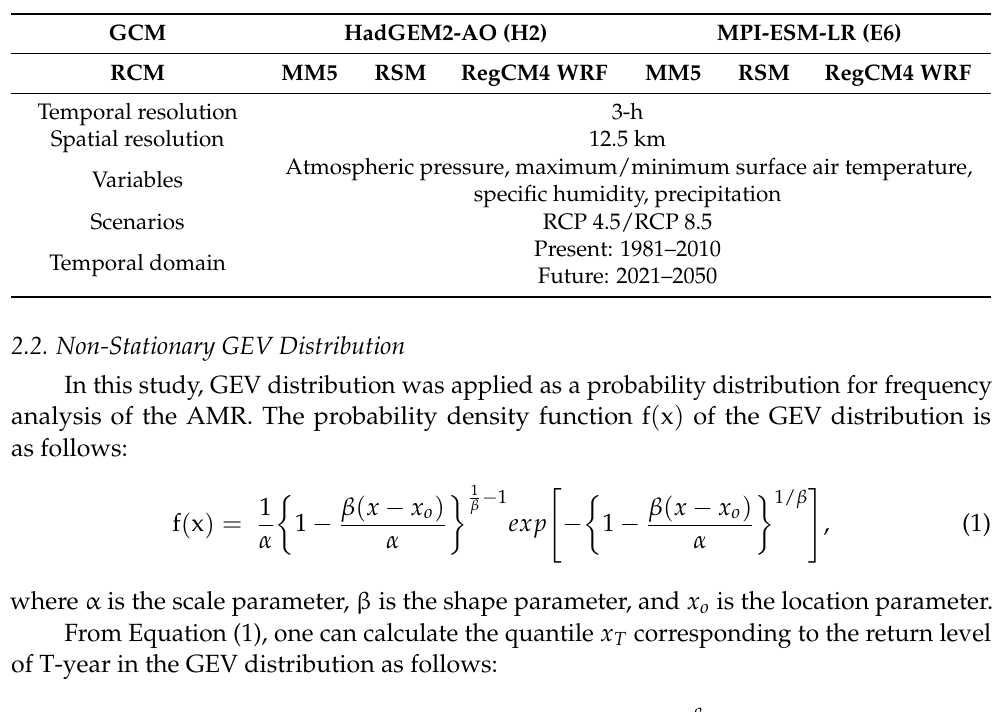
Table 1. Climate model output